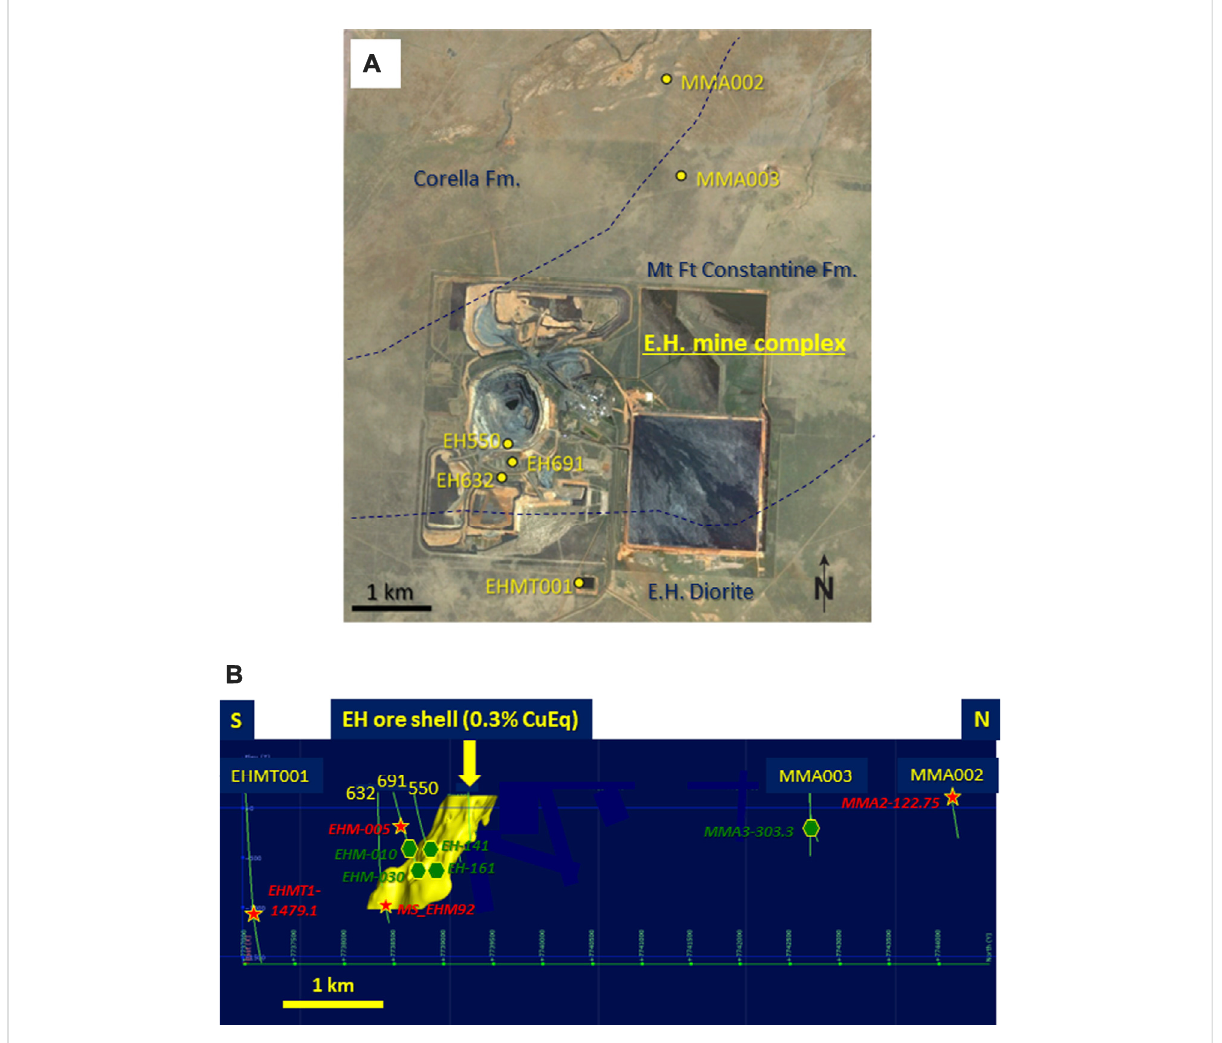
FIGURE 2 (A) Satellite image of the Ernest Henry mine complex and surrounding area. The collar location of drill holes sampled as part of this study are shown on the image. (B) Cross-section (looking west) through the Ernest Henry 0.3% copper equivalent (CuEq) grade shell, illustrating the traces of drill holes sampled in this study. The distance between drill holes EHMT001 and MMA002 is approximately 9 km. Names for samples are provided next to their respective symbols (i.e., star or hexagon). Stars on the cross section are samples included in the main body of this paper, whereas those marked by hexagons are included in the supplementary data attached to this